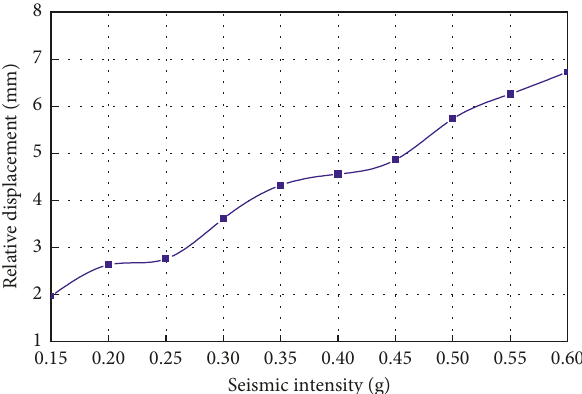
Figure 14: The maximum relative horizontal displacement at the top of the